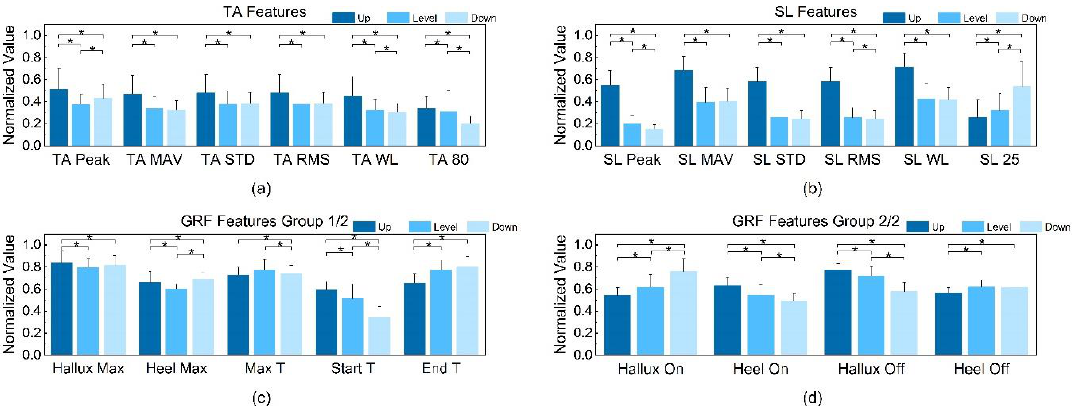
Figure 6. The statistical features of the EMG and GRF in the different terrains: ( a ) TA EMG features. ( b ) SL EMG features. ( c ) Group 1 of GRF features. ( d ) Group 2 of GRF features. (* p < 0.05).